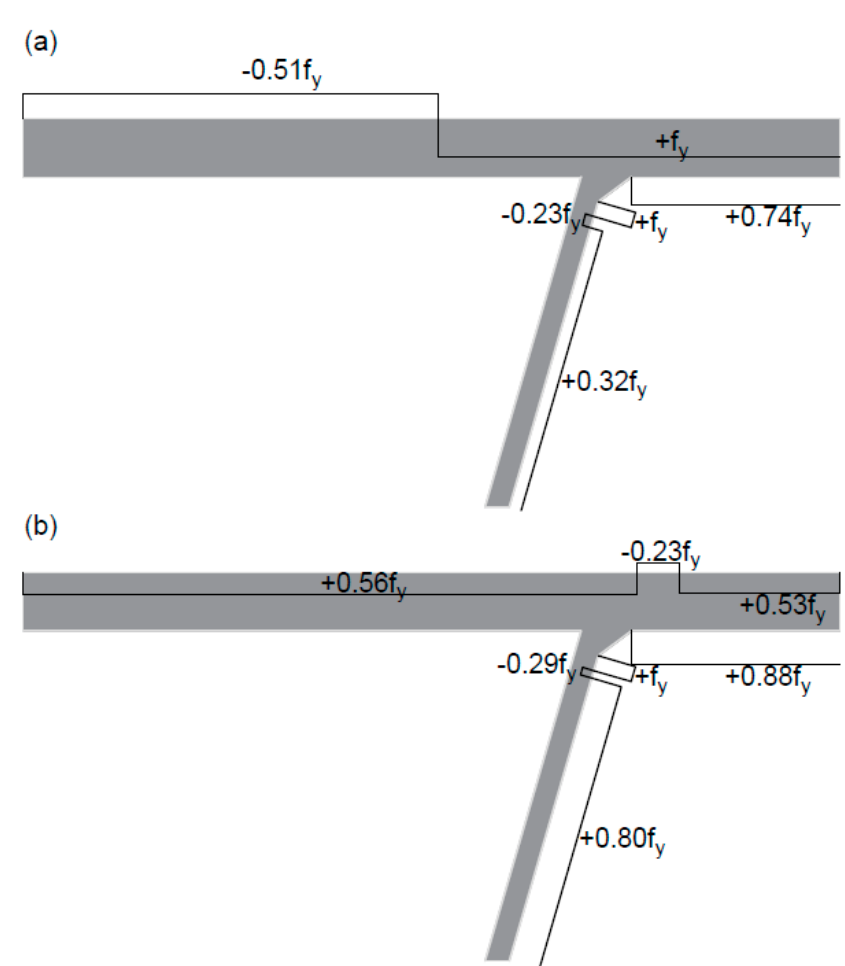
Figure 16. Residual stress distribution of the orthotropic steel deck according FEM for the ( a ) longitudinal and ( b ) transverse directions.